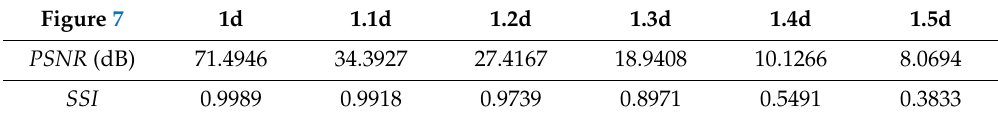
Table 4. Quantitative comparison of recovered images for Figure 7.